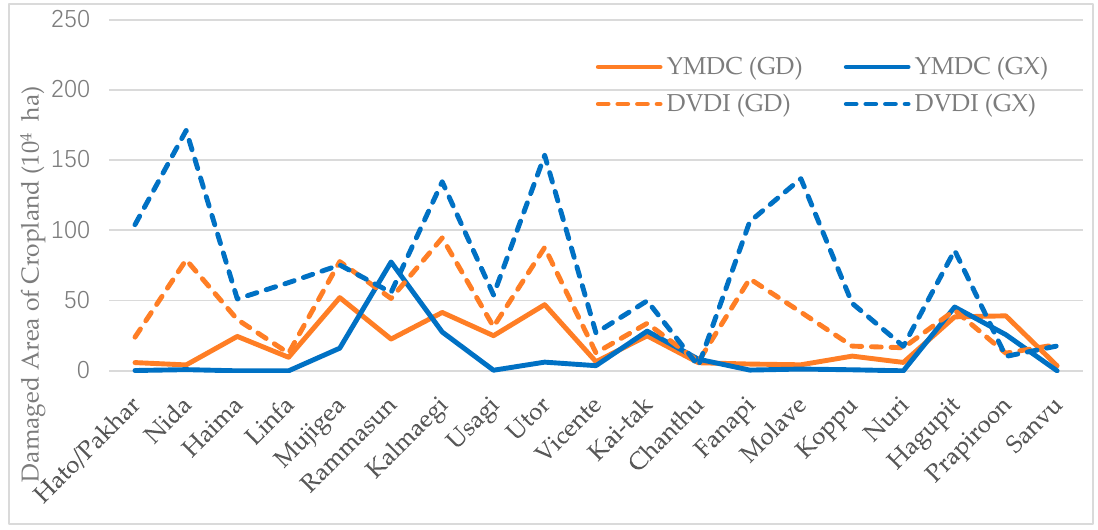
Figure 9. The comparison of the damaged cropland area calculated from DVDI maps for area with moderate or above levels of damage (DVDI, dashed lines) and that obtained from the Yearbook of Meteorological Disasters in China (YMDC, solid lines) (2005–2018). Orange and blue lines are for Guangdong and Guangxi Provinces respectively.